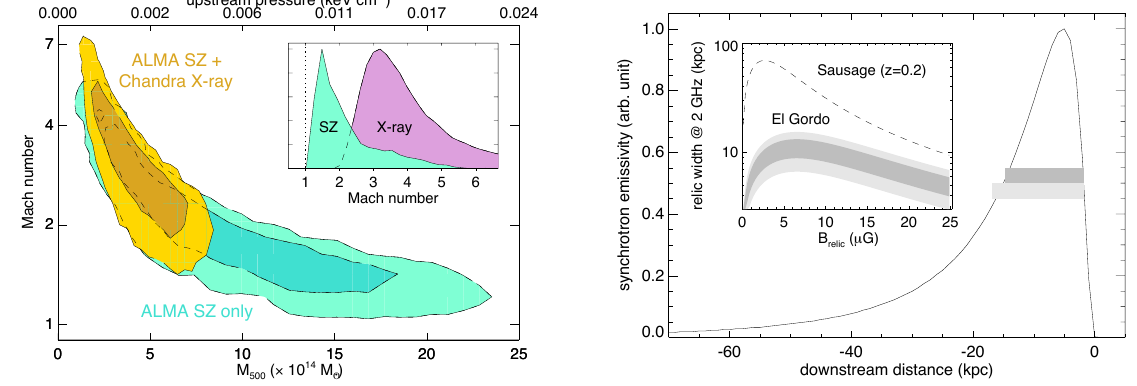
Figure 6. Results from the thermal/non-thermal modeling of the El Gordo NW relic shock (from [16]). Left: Joint likelihood contours for the shock Mach number and the cluster mass/pre-shock pressure. Darker and lighter colors mark the 68% and 95% credible regions. The inset figure shows the marginalized Mach number distribution from independent SZ and X-ray analyses. Right: Relic magnetic field strength from the width of its synchrotron emissivity region. The solid line shows a deprojected emissivity model, and the horizontal grey bands mark the maximum relic width at 68% (dark grey) and 95% (light grey) confidence, as estimated from a joint modeling of the radio synchrotron and the X-ray/SZ